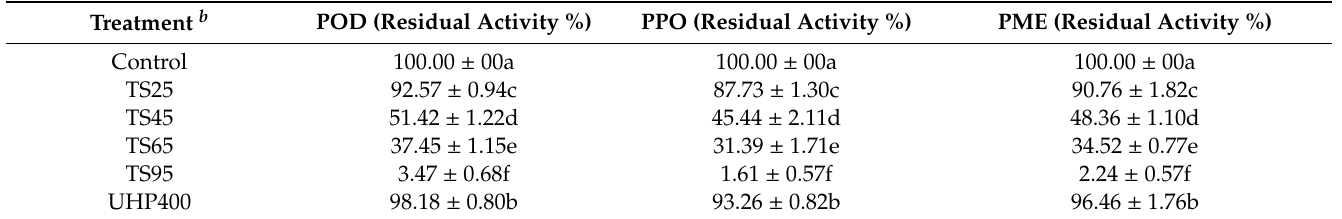
Table 2. E ff ect of di ff erent treatments on the residual activity percentage of POD, PPO and PME in mango juice a .